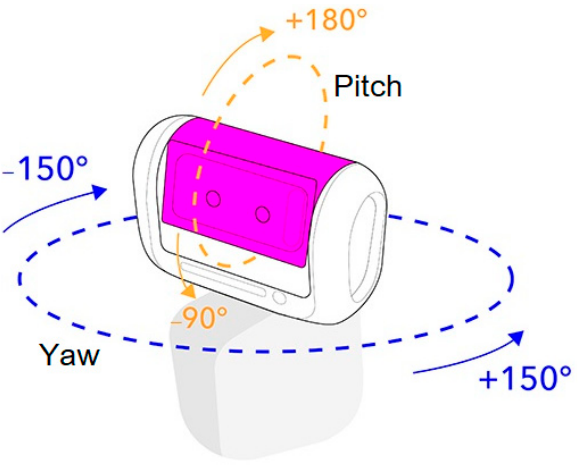
Figure 7. Head angle ranges in the navigation layer [28].